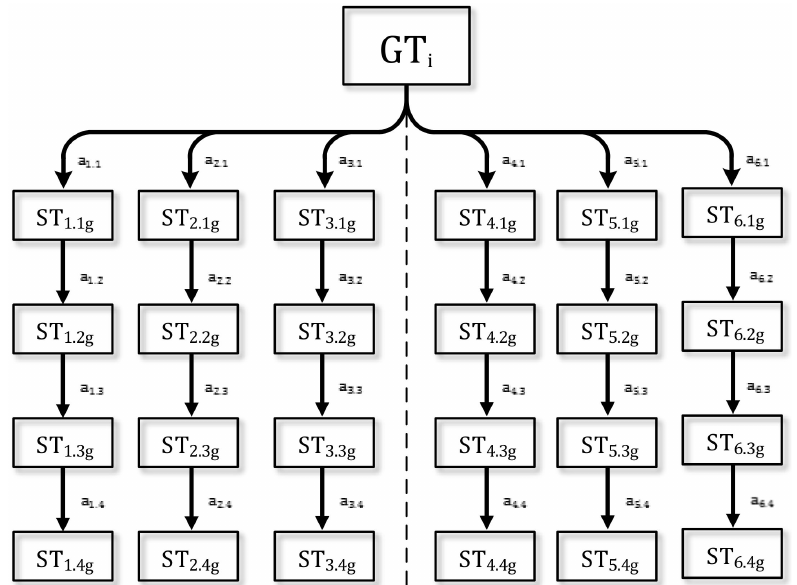
Figure 1. Oriented graph “Protected resources of TDTN”.